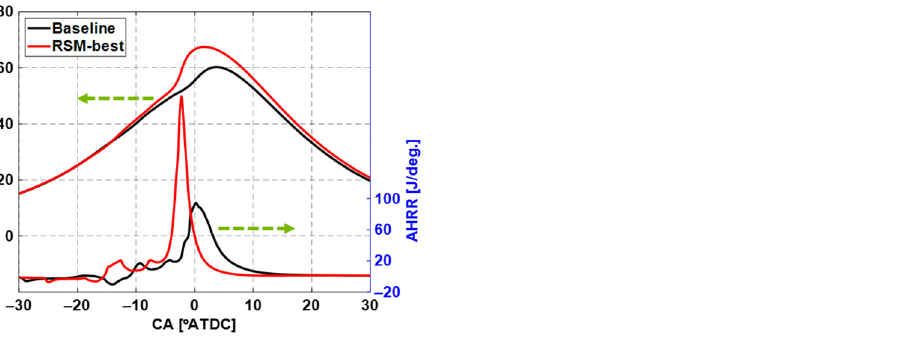
Figure 6. Comparison of in-cylinder pressure and apparent heat release rate (AHRR) between baseline and RSM-best cases.